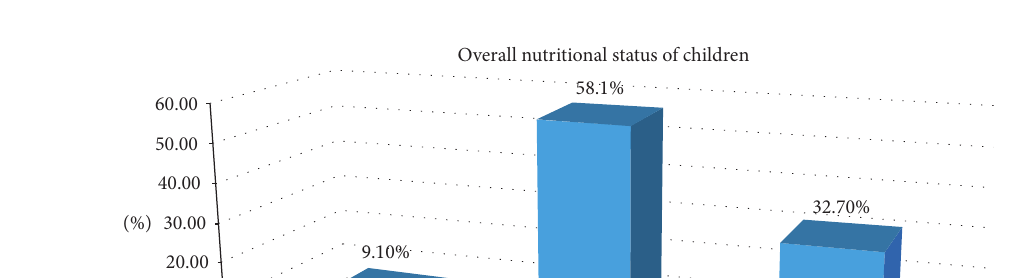
Spend free time